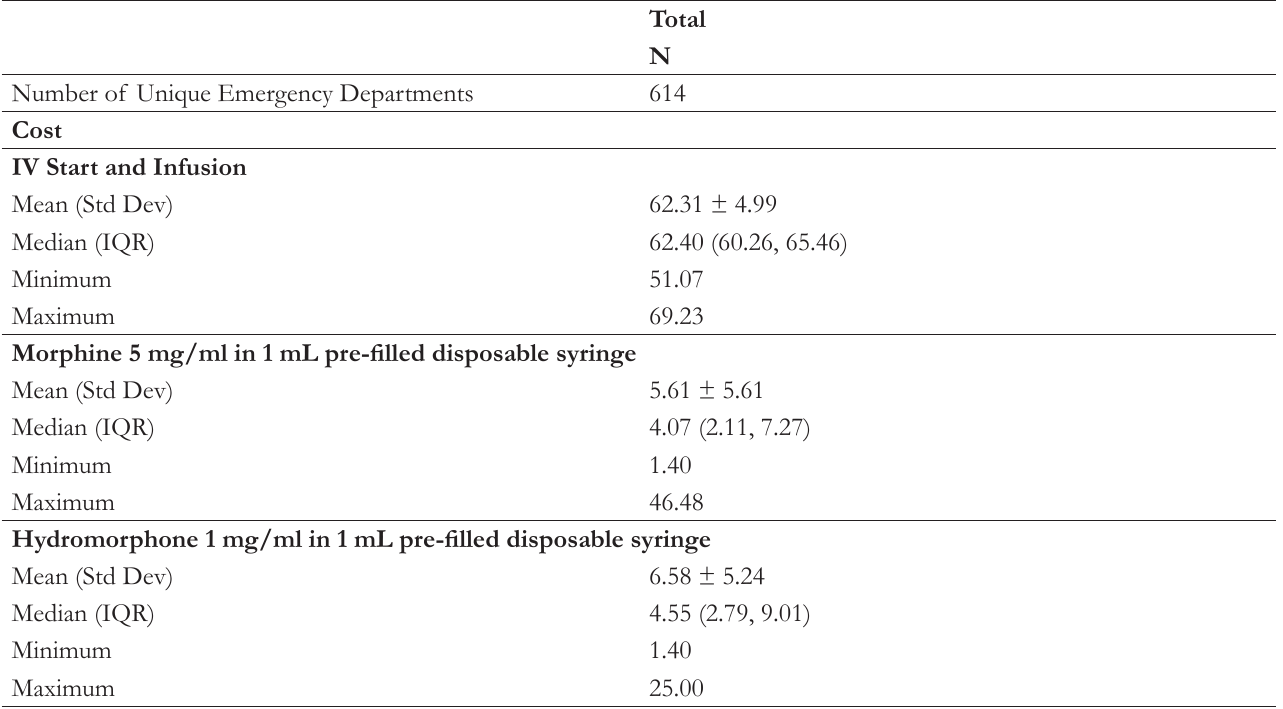
Table 4. Individual Costs (2016